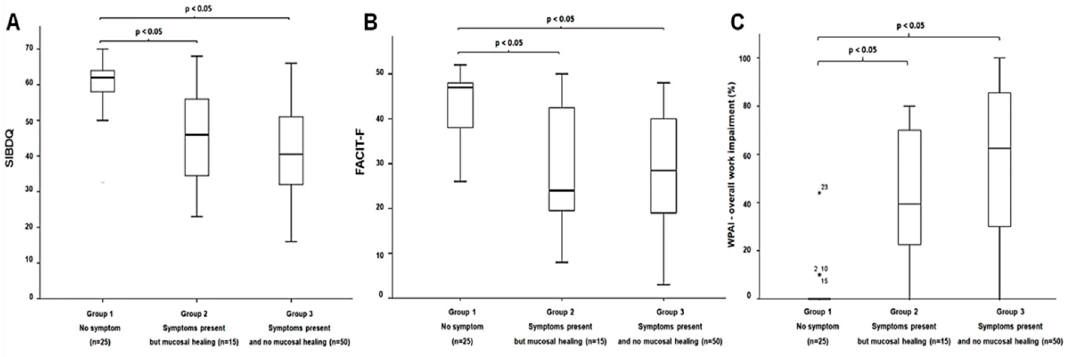
Figure 2. (A) SIBDQ, (B) FACIT-F, and (C) WPAI in UC patients categorized by ClinPRO2 and mucosal healing.